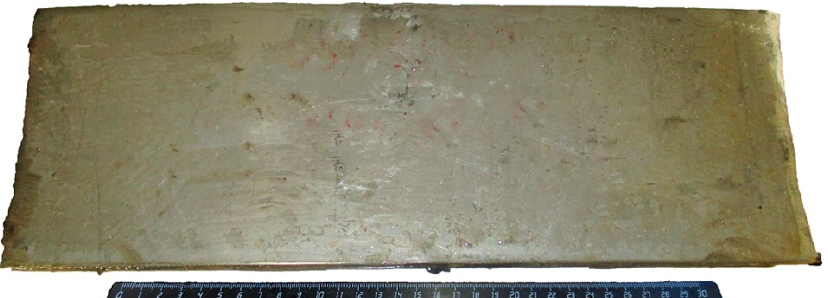
Figure 4. Bimetal sheet after EW.